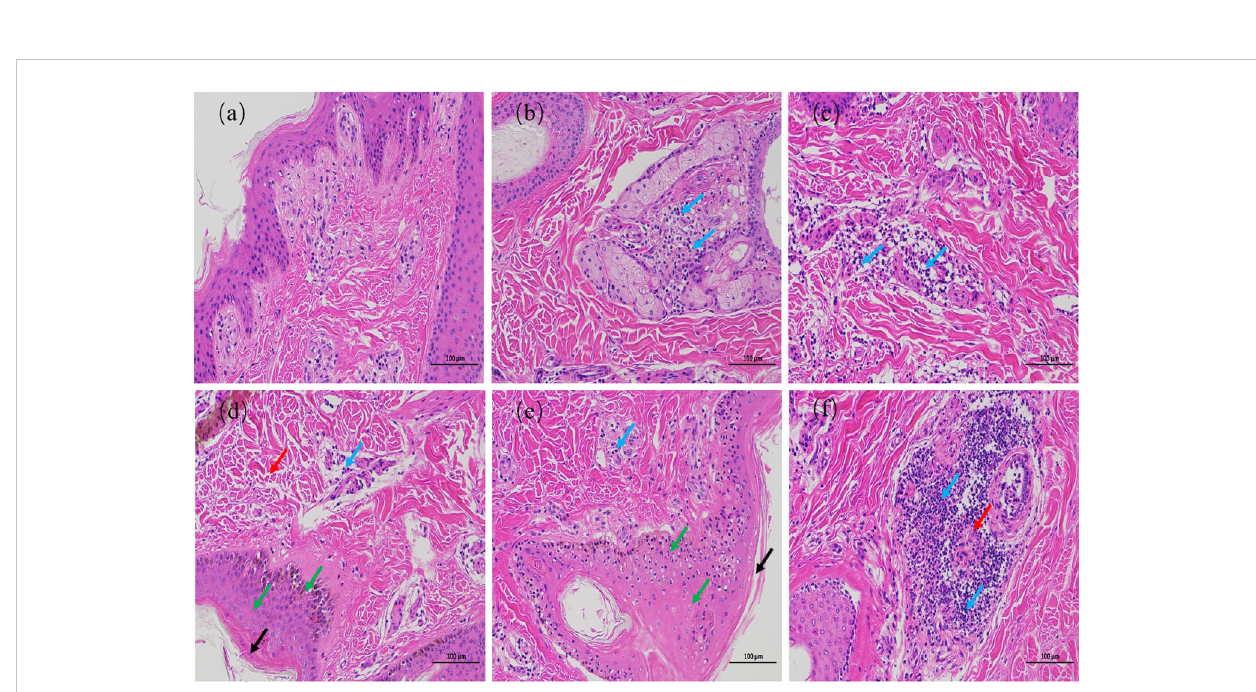
FIGURE 2 Hematoxylin and eosin staining images of intertoe skin explants infected with F. necrophorum over 72 h. (A) Skin explants infected with F. necrophorum at 0 h, (B) 12 h, (C) 24 h, (D) 36 h, (E) 48 h, and (F) 72 h. Blue arrows: lymphocyte in fi ltration in the dermis; Black arrows: hyperkeratosis of the epidermis; Red arrows: hair follicle, sweat gland, and sebaceous gland necrosis; Green arrows: cell degeneration, necrosis, and nuclear pyknosis. (Scale bar = 100 µm)